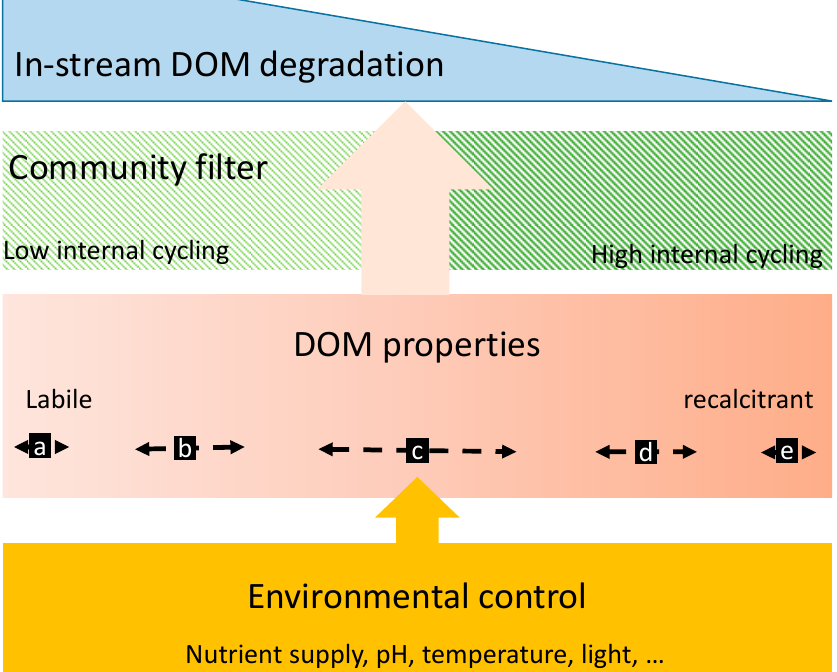
Figure 6. Concept of intrinsic (dissolved organic matter (DOM) properties) and external (environmental) controlling factors of aquatic DOM degradation, with microbial communities acting as a filter. Different DOM components (a–e) are expected to show a varying degree of degradability, ranging from highly labile ( a ) to highly recalcitrant ( e ), which may change due to the influence of the environment (indicated by the horizontal dashed arrows). The filter effect of the community is supposed to depend on the degree of internal cycling.